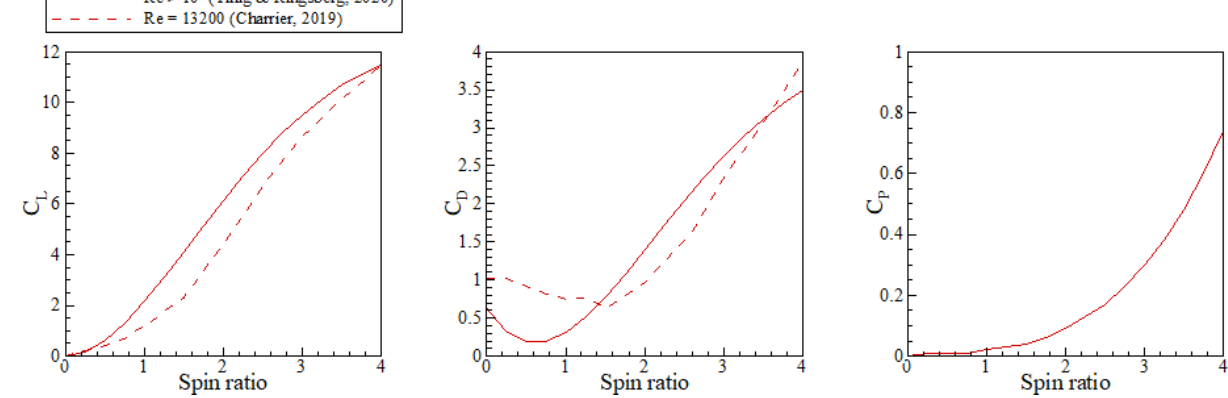
Figure 3. Comparison of aerodynamic coefficients of Flettner rotors according to Charrier (1979) and Tillig and Ringsberg (2020).